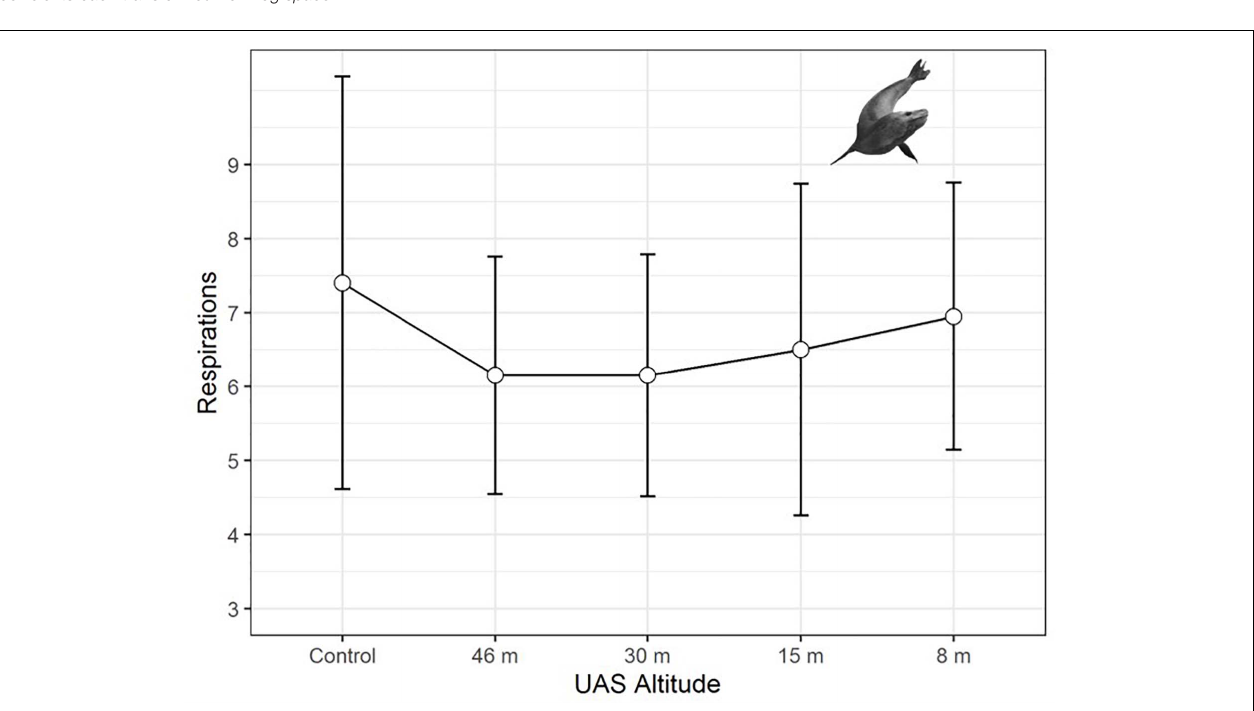
differences in molt stage apparently did not affect their reaction to the presence of UAS ( Table 8